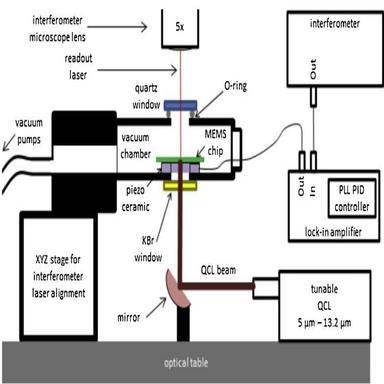
Schematic of setup for Nanomechanical Infrared (NAM-IR) Spectroscopy with interferometric readout and Quantum Cascade Laser (QCL) for excitation .